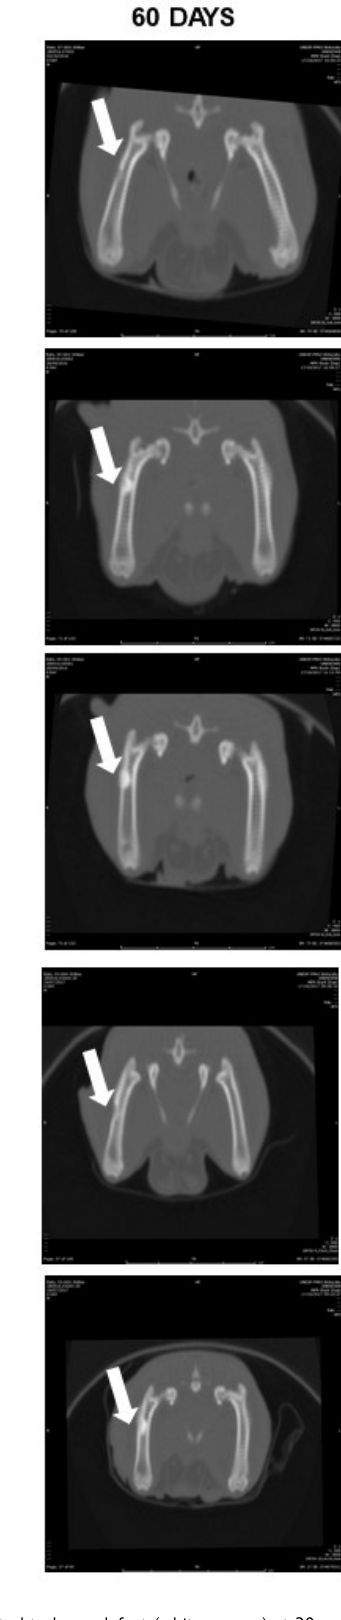
Figure 6. Representative images on coronal plane of the right femur of rats submitted to bone defect (white arrows) at 30 and 60 days after surgical procedure by CT